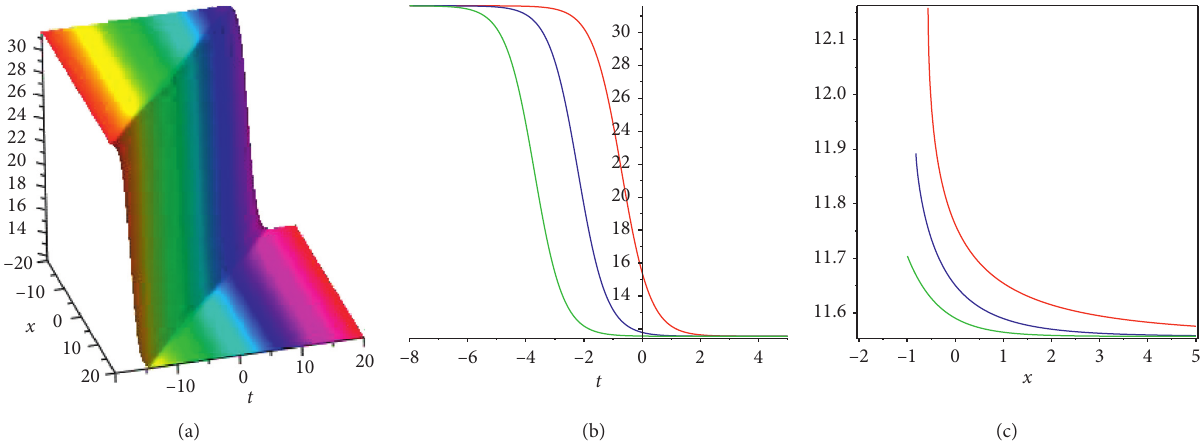
( x, t ) at A � 1 ,B � 2 ,a � 3 ,b � 2 ,k � 1 . 5 , ω � 2 , β � 3 , c � − 1 , and α � 1 for (a) 3D plot and (b) and (c) 2D 1 0 0